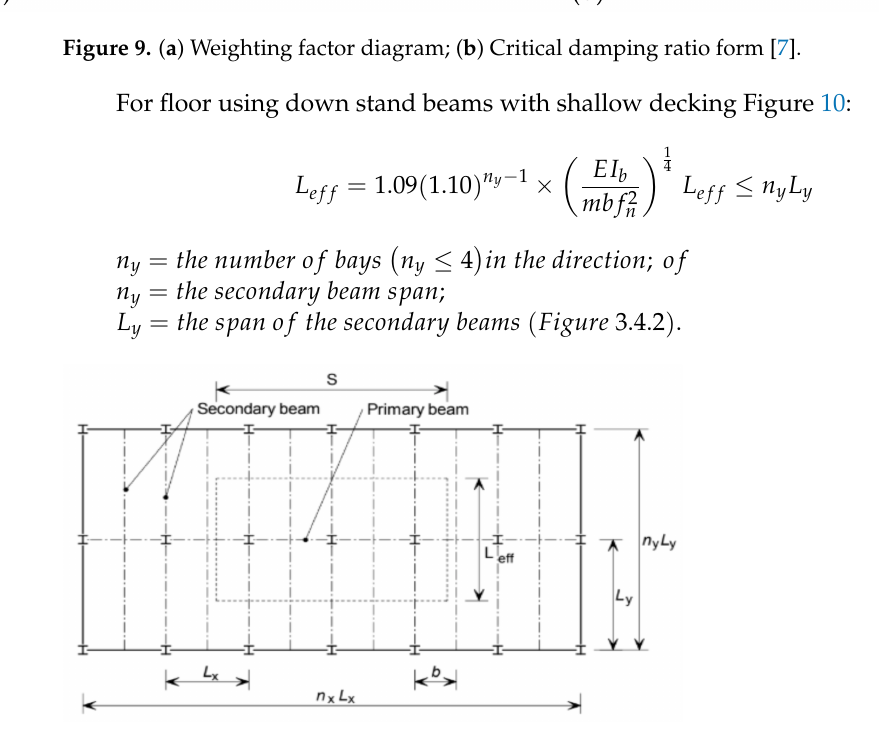
Figure 10. Definition of variables used to establish effective modal mass